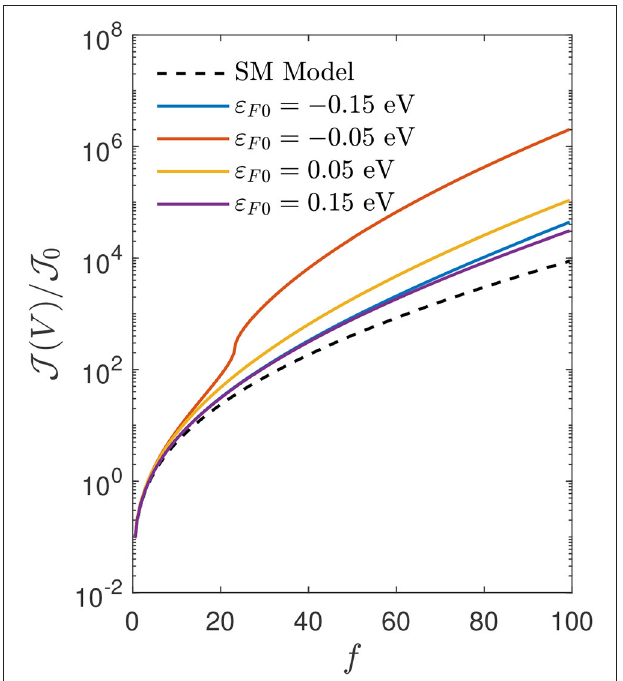
FIGURE 2 | Current-voltage characteristics of thermionic carrier injection in graphene/organic Schottky contact at various intrinsic Fermi level, ε F 0 , with organic semiconductor dielectric constant ε T 300 K. =